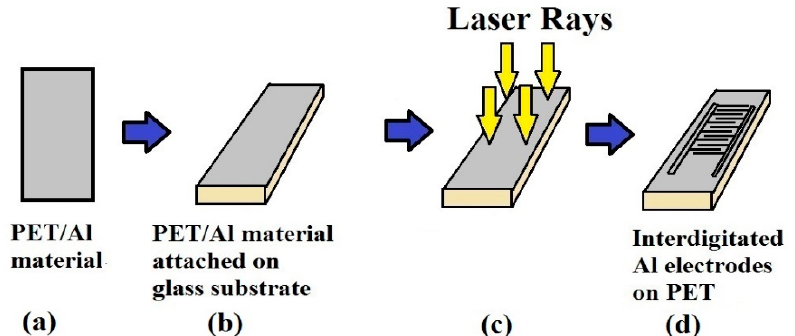
Figure 7. Schematic diagram for the fabrication of the Al–PET sensors. ( a , b ), The metalized polymer film was attached to the glass substrate, ( c ) direct laser cutting on the metallic side of the film formed the interdigitated electrodes, ( d ) on the sensor patch. Reproduced from Nag, A., Mukhopadhyay, S.C. and Kosel, J., 2016. Tactile sensing from laser-ablated metallized PET films. IEEE Sensors Journal, 17(1), pp.7–13 [2].